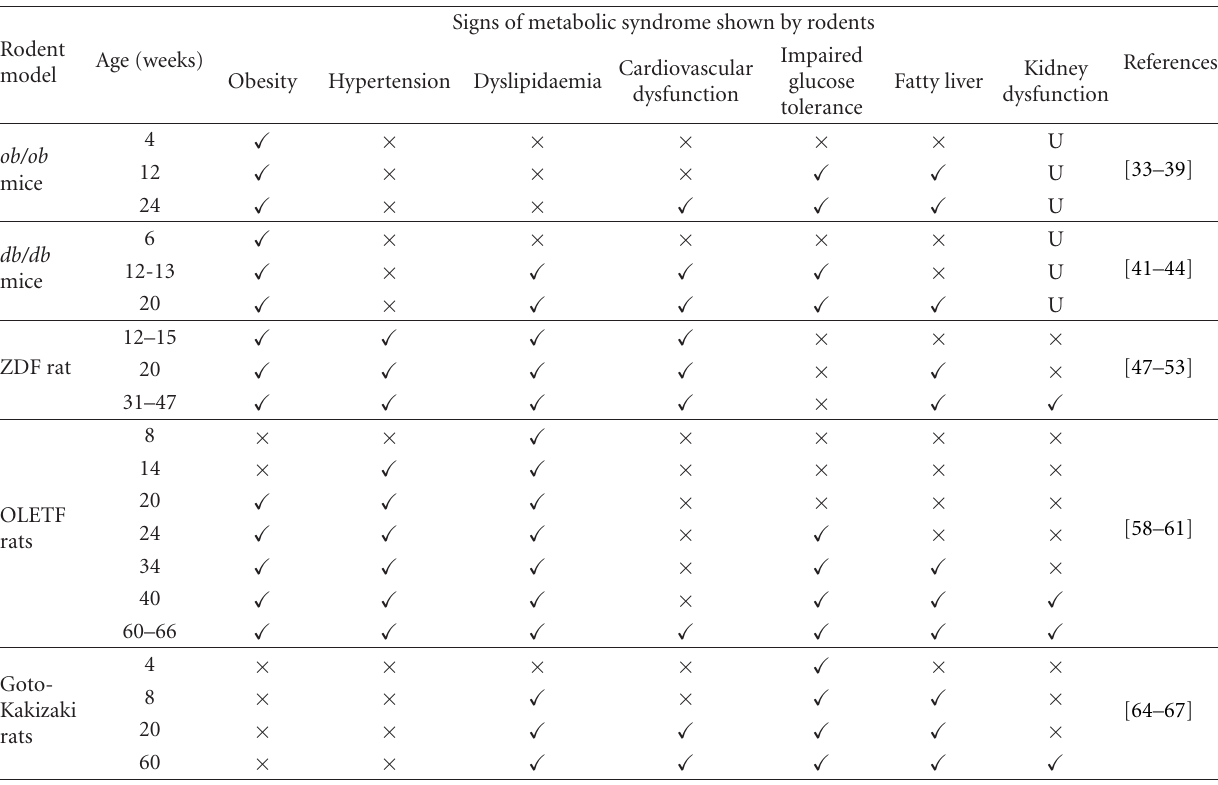
This table represents the signs of metabolic syndrome at di ff erent ages. The symbols (cid:2) and × indicate the presence and absence of these signs of metabolic syndrome at that age, respectively, whereas U indicates unavailability of the data. The table indicates that age is an important parameter since some of the signs are developed in very young rodents whereas others take much longer to